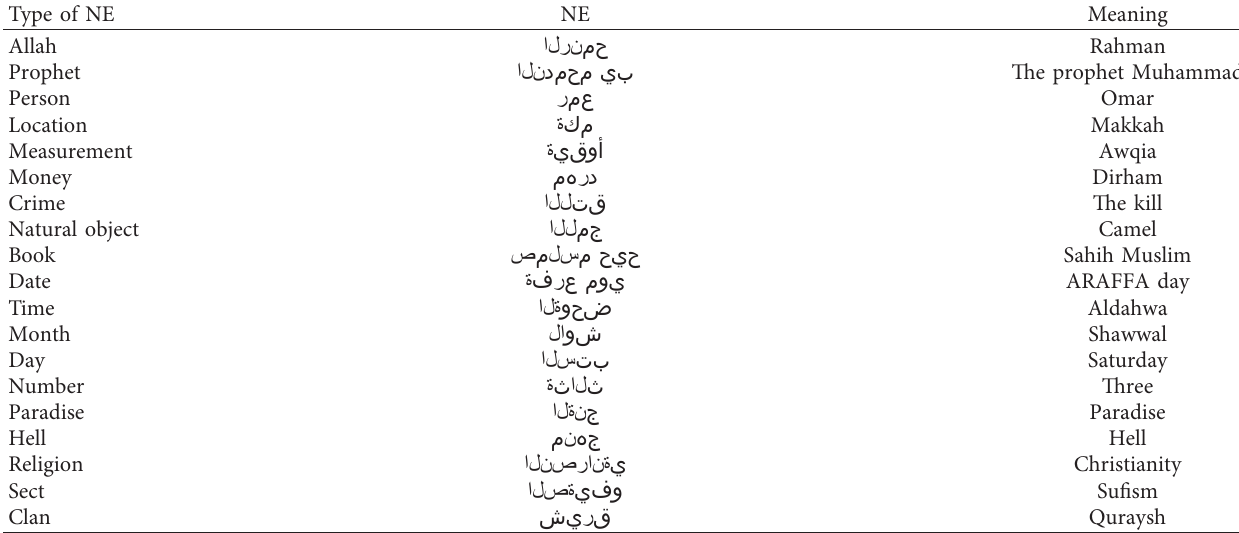
Table 6: Examples of gazetteers.